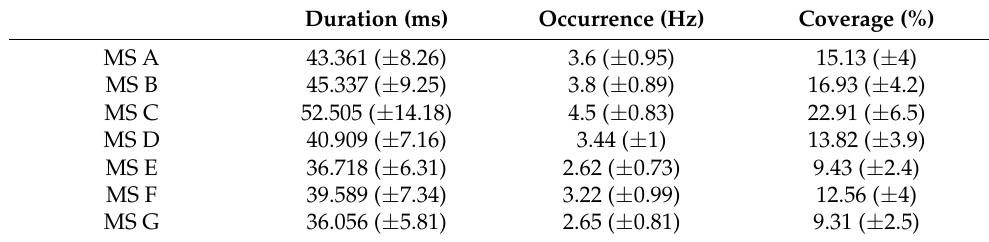
Figure 1. ( A ) Optimal number of microstates based on the Silhouette Coefficient values for each number of k ; number of estimated clusters equals 7. ( B ) Mean scores of each ARSQ dimension. Dark blue lines indicate standard deviation. ( C ) Seven microstate group ‐ level topographies. ( D ) Spatial correlation coefficients between group ‐ level topographies. ( E ) Intraclass Bayesian Pearson correlation coefficients between ARSQ dimensions. * 10 > BF 10 > 3, *** BF 10 > 100. Table 1. Temporal parameters of